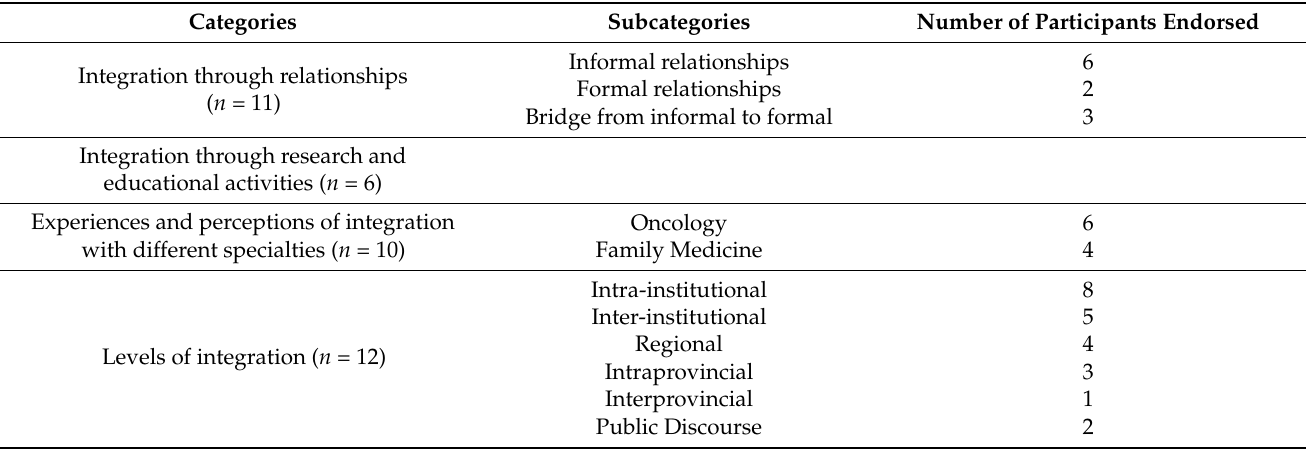
Table 2. Qualitative Results